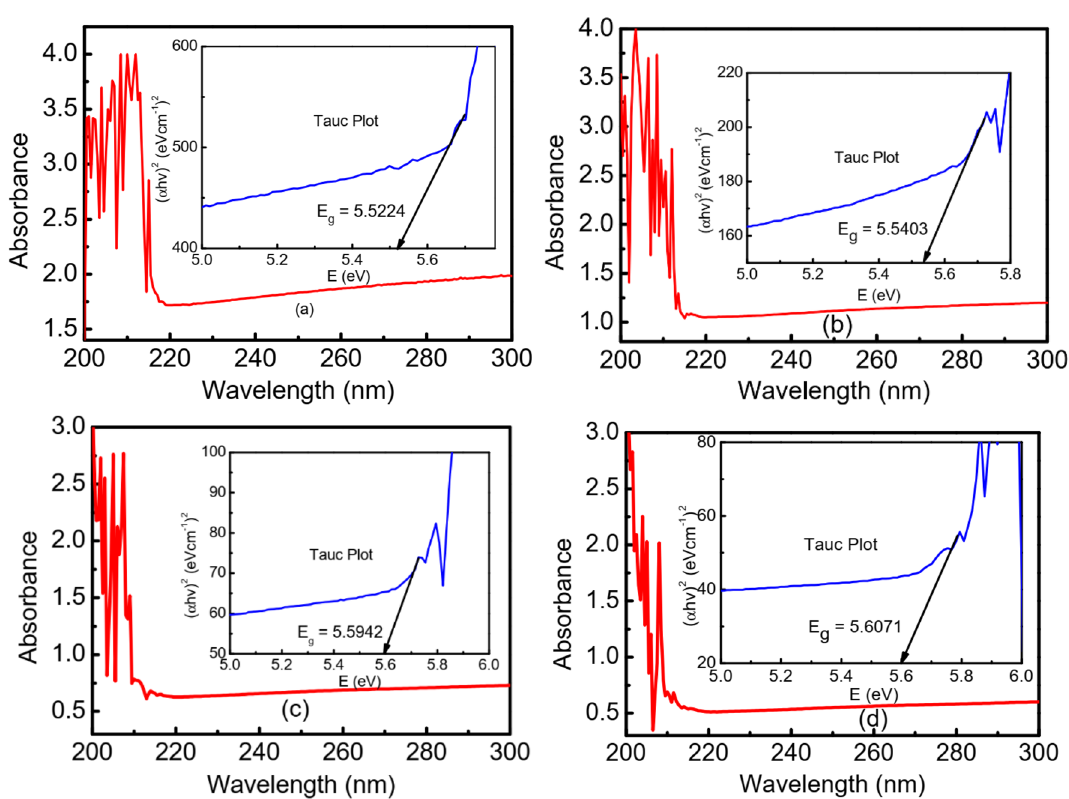
Fig. 8 UV spectrum of the prepared LTO material of a GC1 b GC2 c GC3 d